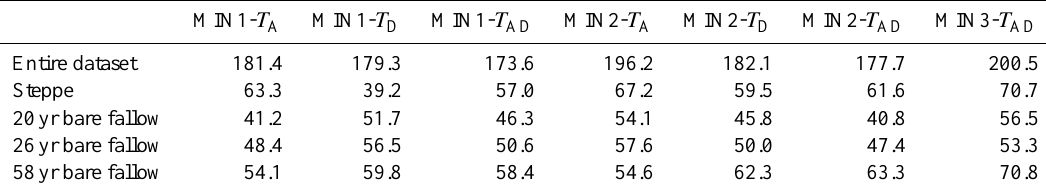
Table 3. Bayesian Information Criterion (BIC).